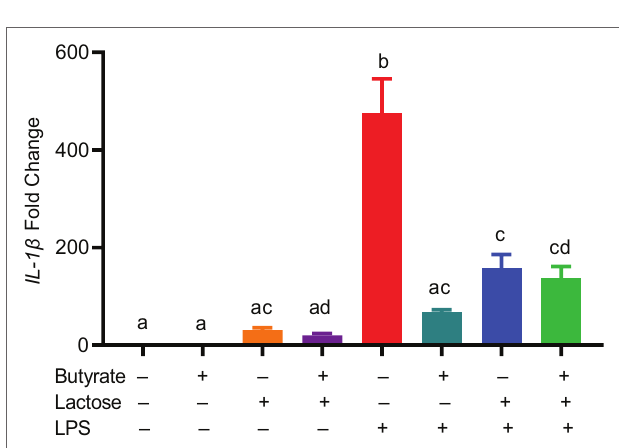
FIGURE 8 | Suppression of lipopolysaccharide (LPS)-induced interleukin 1 β ( IL-1 β ) by butyrate and lactose. Chicken HD11 cells were treated in duplicate with 2 mM butyrate, 0.1 M lactose, or in combination for 1 h, followed by stimulation with 10 ng/ml LPS for another 3 h and RT-qPCR measurement of IL-1 β gene expression. The results presented means ± SEM of two independent experiments. The bars without common superscript letters denote statistical significance ( p < 0.05) as determined by one-way ANOVA and post hoc Tukey’s test.